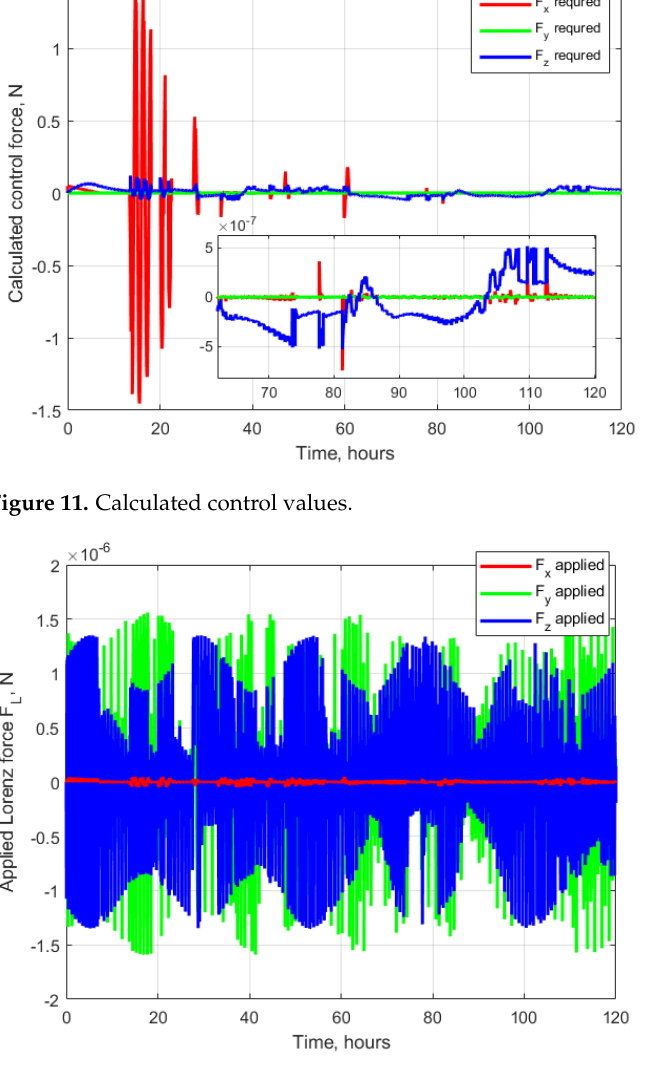
Figure 12. Applied Lorenz force.